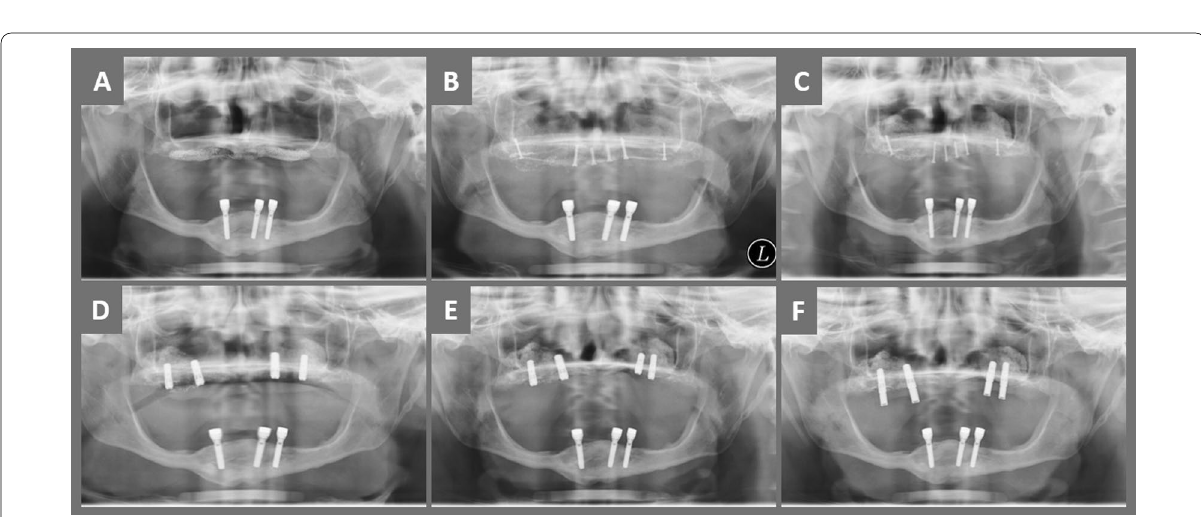
Fig. 3 Panoramic radiographs: A preoperative, B immediately after augmentation, C after 3 months, D 5 months postoperatively after removal of the mini screws and implant insertion, E 11 months and F 23 months